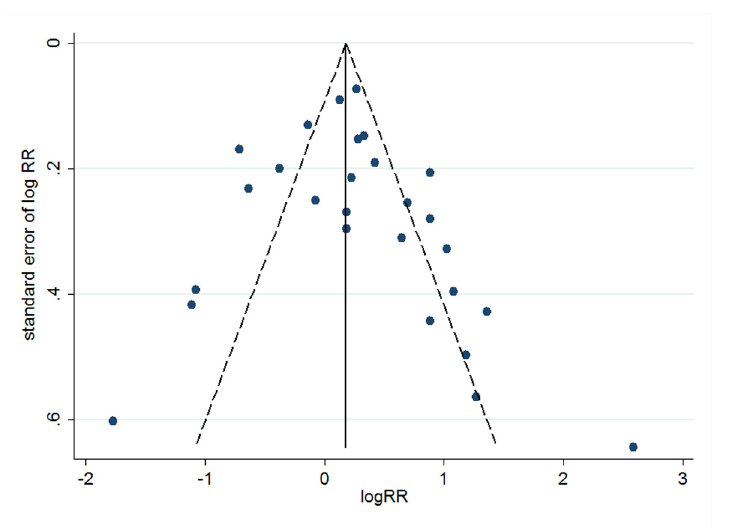
Fig 5. Publication bias within cancer overall